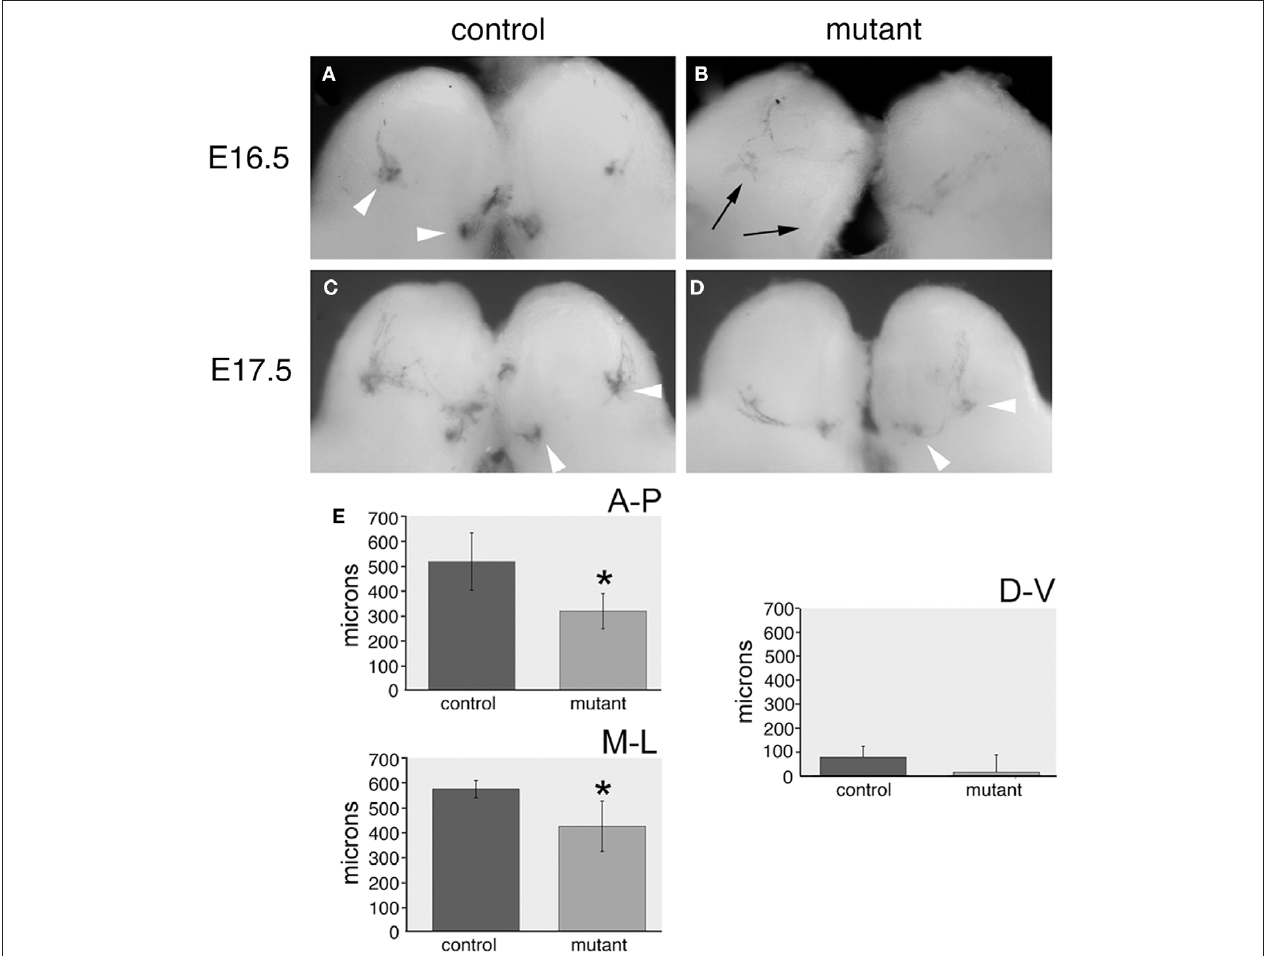
control littermates show glomerular convergence to typical locations targeted by SR1 -expressing OSNs (arrowheads). (D) SR1 -positive OSNs also converge in transgenic animals, but these glomeruli appear physically closer to one another relative to control animals. (e) Quantitation of the convergence phenotype shows mutant glomeruli are significantly closer to one another in the anterior–posterior ( p < 0.005) and medial–lateral dimensions ( p < 0.05), but their relative separation is essentially unchanged along the